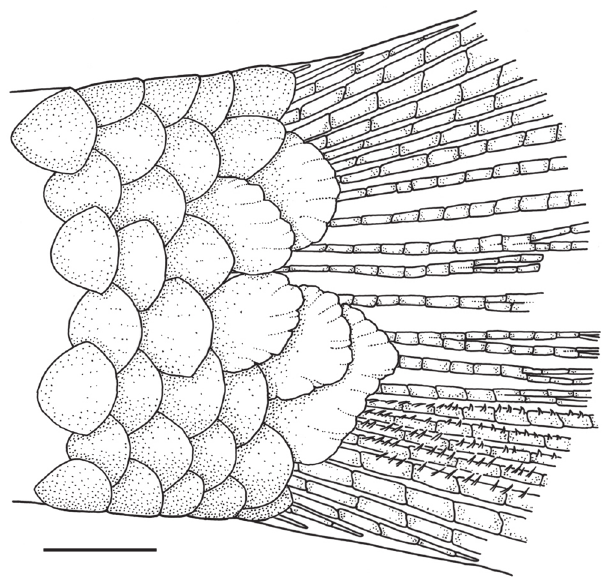
Fig. 5. Macropsobrycon uruguayanae , mature male, MCP 20900, 34.2 mm SL, left side lateral view of the terminal portion of the caudal peduncle and caudal-fin base, showing modified scales and distribution of the “spinelets” on the caudal-fin rays. Scale bar = 1